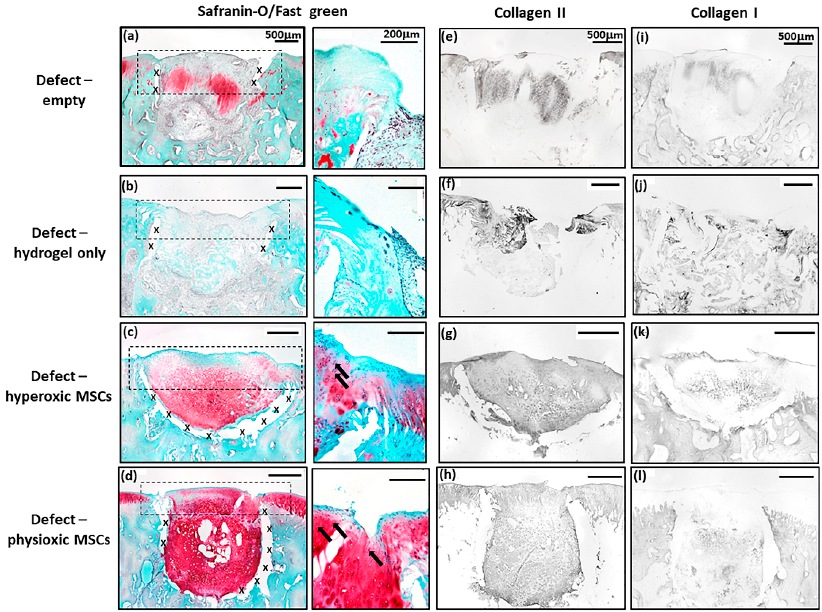
Figure 7. Representative images of ( a – d ) Safranin-O / Fast green, ( e – h ) collagen II and ( i – l ) collagen I staining for ( a , e , i ) empty defect, ( b , f , j ) hydrogel only, ( c , g , k ) hyperoxia and ( d , h , l ) physioxia treated post-trauma defects at 12 weeks post treatment. Box dotted line represents cartilage region evaluated for Sellers score and cross (x) signifies artefacts in the section. Arrows depict chondrocytes / chondrocytic columns in the cartilage layer.